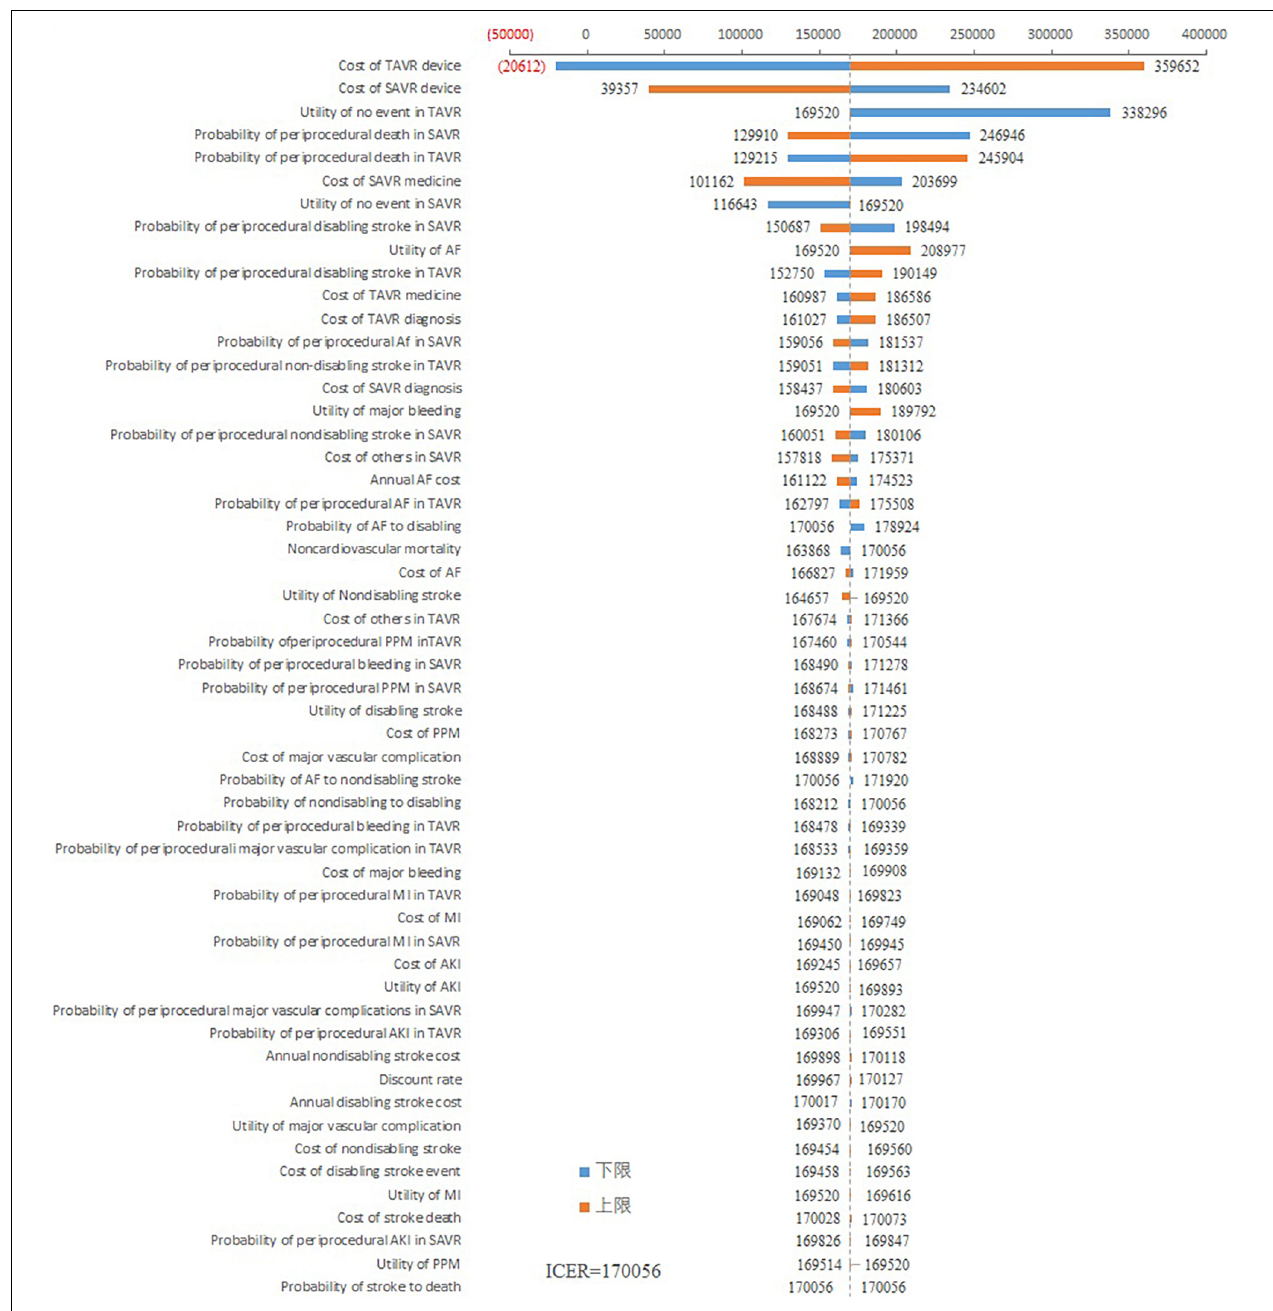
FIGURE 2 | Tornado diagram based on the one-way sensitivity